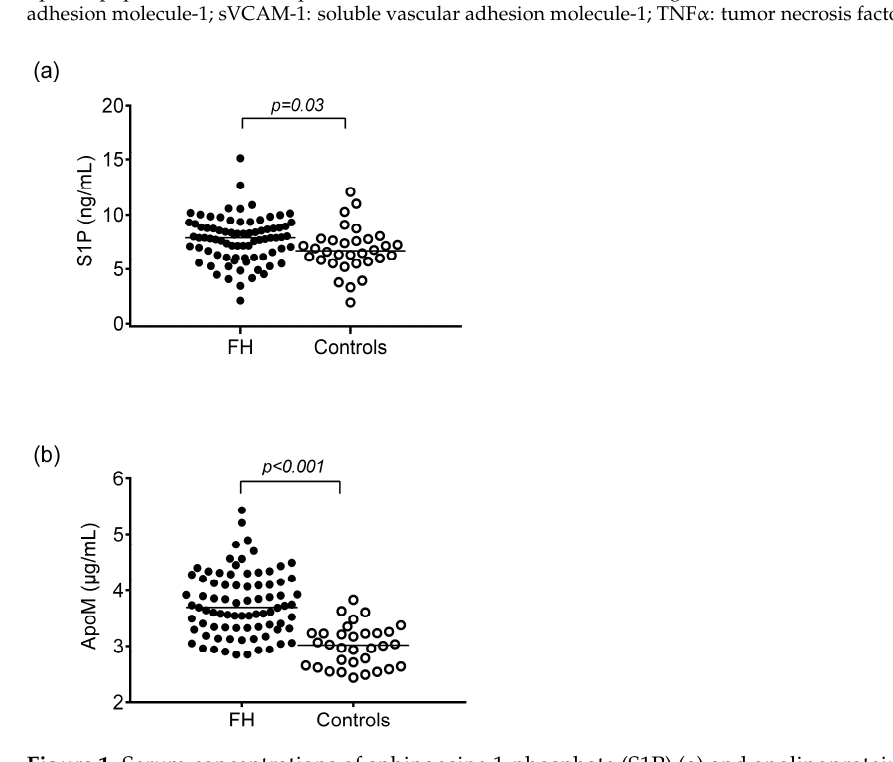
Figure 1. Serum concentrations of sphingosine 1-phosphate (S1P) ( a ) and apolipoprotein M (ApoM) ( b ) in patients with heterozygous familial hypercholesterolemia (HeFH) and controls. There were no significant differences in ApoM and S1P concentrations between HeFH patients with (VC) or without vascular complications (nonVC), including previous acute myocardial infarction, stroke, carotid artery atherosclerotic disease, or peripheral arterial disease (ApoM: VC 3.79 ± 0.62 vs. nonVC 3.73 ± 0.53 μ g/mL, p = 0.7; S1P: VC 7.63 ± 1.08 vs. nonVC 7.75 ± 2.06 ng/mL, p = 0.8, respectively). We could not find significant differences in the S1P/ApoM ratio between FH patients and controls (2120 ± 700 vs. 2290 ± 740; p = 0.22). The proportion and absolute amount of VLDL and IDL subfractions were signifi- cantly higher in HeFH patients compared to control individuals. Both proportions and levels of large- and small-density LDL subfractions were significantly higher while mean LDL size was significantly lower in HeFH patients compared to controls. Furthermore, a lower percentage and concentration of large and intermediate HDL subfractions, in con- trast to a higher percentage and concentration of small HDL subfractions, were found in HeFH patients compared to control subjects (Table 2). Table 2. Concentrations and proportions of lipoprotein subfractions in study participants. Values are expressed as mean ± SD or median (lower quartile, upper quartile). FH Patients